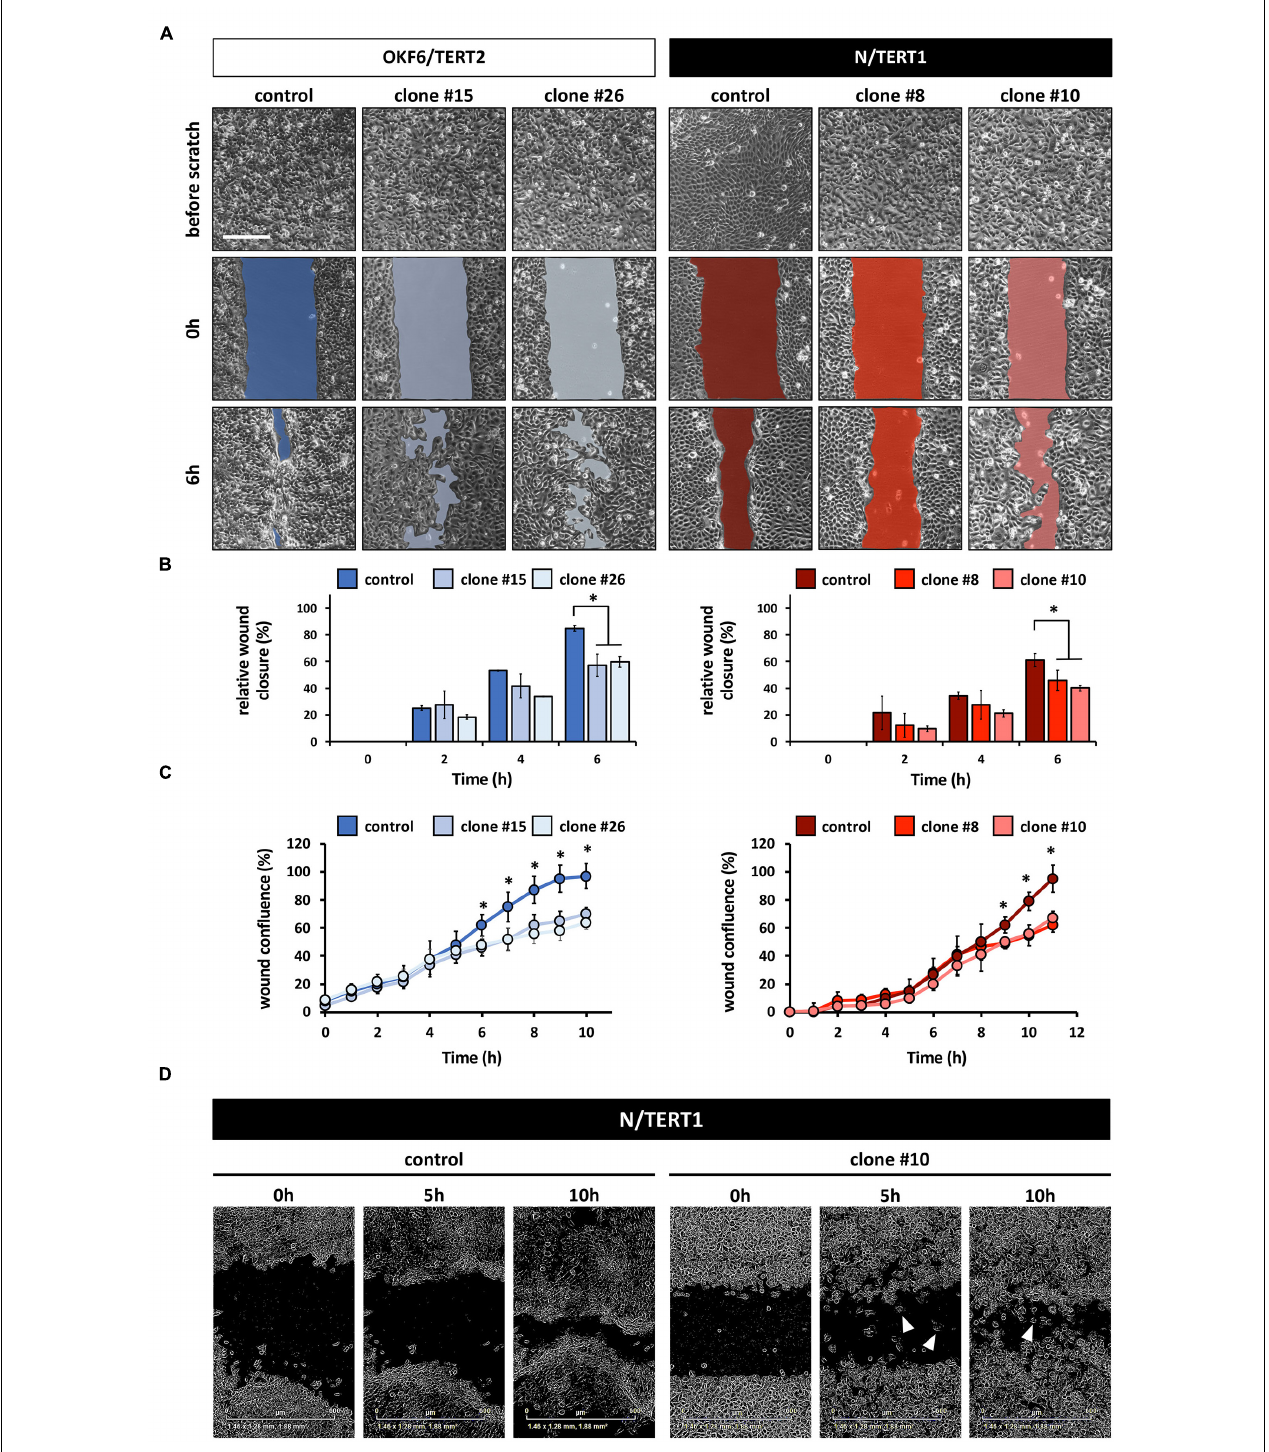
FIGURE 4 | (A) Live Imaging pictures of the in vitro scratch at the indicated times after wounding the confluent monolayer and before scratching. Left side: OKF6/TERT2; Right side: N/TERT1. Scale bar: 500 µ m. (B) Quantification of the manual scratch shows a delay of the wound closure in the absence of IRF6. ∗ p < 0.05 control vs. clones. (C) Quantification of an automated live imaging scratch assay confirms impaired closure of the scratch in the IRF6 knockout keratinocytes compared to control. ∗ p < 0.05 control vs. clones. (D) Pictures of N/TERT1 control and N/TERT1 clone #10 taken at the time of scratching (0 h), 5 h, and 10 h shows that lack of IRF6 results in significantly more cells that move randomly as single cells (arrowheads, right side) compared to control (left side).